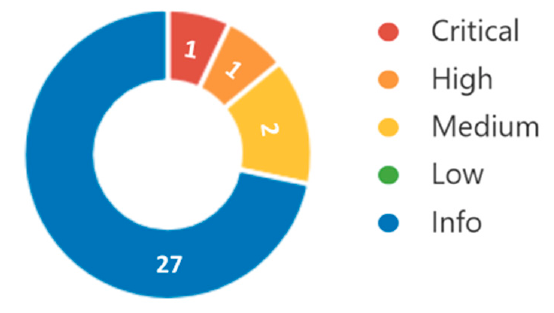
Figure 4. The vulnerability scanning summary report.